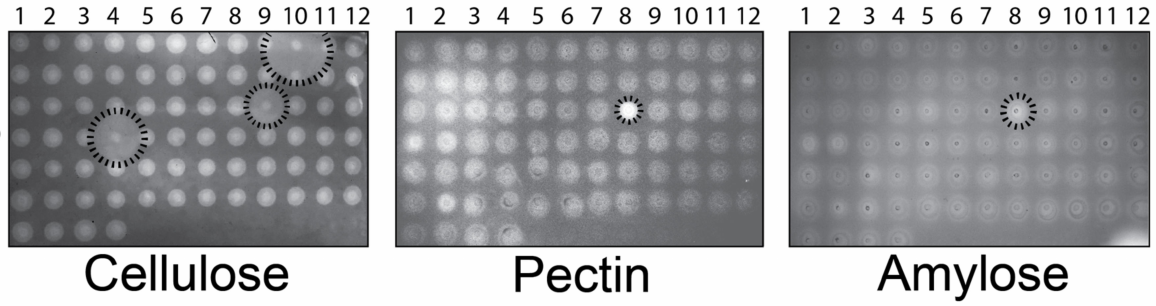
Figure 1. GHs expressed by P. pastoris can hydrolyze CMC, amylose, and pectin in agar. Recombinant P. pastoris strains were arranged in a 96-well plate format and printed onto BMMY agar containing methanol to induce the expression of GH. The cells were washed from the plates before staining for the presence of polysaccharides. The lack of staining indicated polysaccharide hydrolysis, as highlighted at positions A10, C8, C9, and